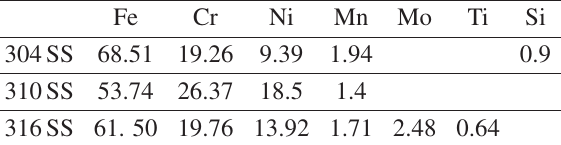
Table 1. Chemical composition of stainless steels studied (mass %).